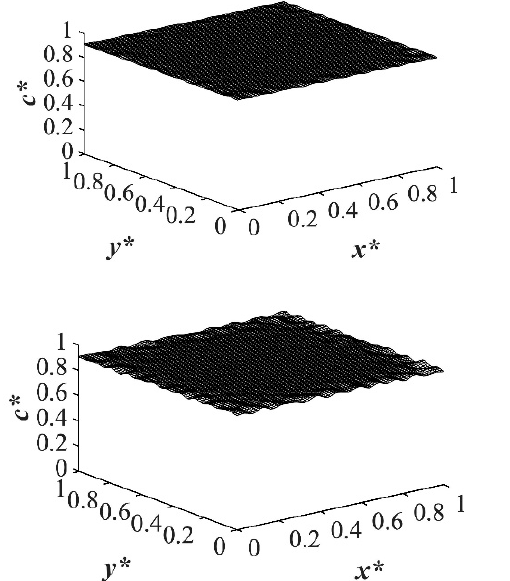
Figure 13. The influence of initial solution temperature on phase separation through TIPS process with two different dimensionless initial solution temperatures of ( a ) T * = 1.05 and ( b ) T * = 1.03 to the same quench temperature of T * q2 = 0.99 at time t * = 5.03 × 10 − 4 . 4. Conclusions In this study, the influence of spatial and temporal temperature gradients on the ther- mally induced phase separation process was investigated through modelling and simula- tion in two- dimensions by coupling the nonlinear Cahn-Hilliard equation considering all temperature-dependent parameters and the Fourier heat transfer equation considering the influence of enthalpy of demixing. The Flory-Huggins free energy theory, the Rouse model, and slow mode theory were employed for the unentangled polymer chain diffu- sion. Different boundary conditions, initial polymer concentrations, and quench depths were evaluated. It was verified that the influence of heat transfer on phase separation